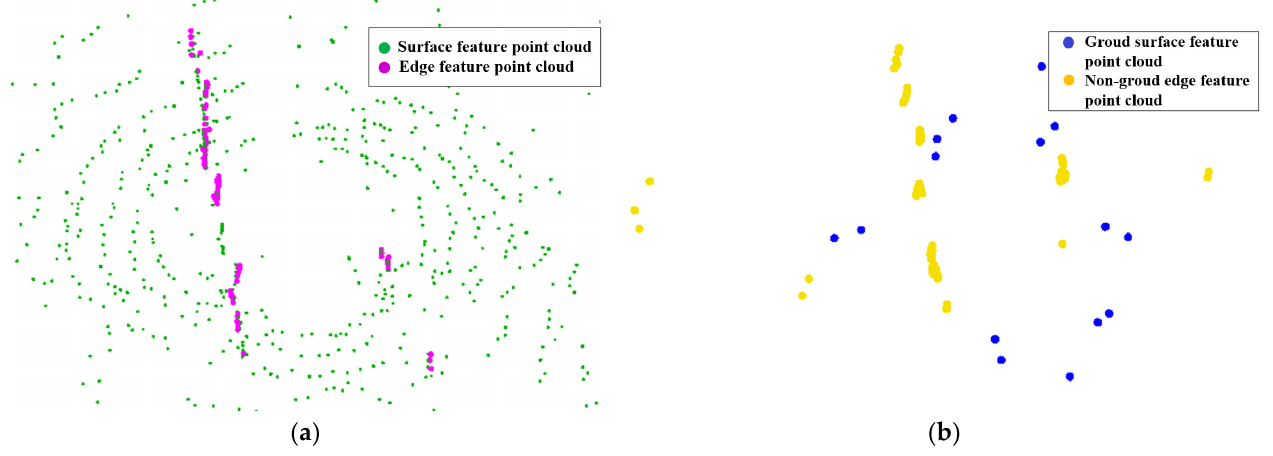
Figure 7. Point cloud feature classification: ( a ) Surface feature point cloud and edge feature point cloud; ( b ) non-ground edge feature point cloud and ground plane feature point cloud. After downsampling the point cloud by feature classification, the surface features